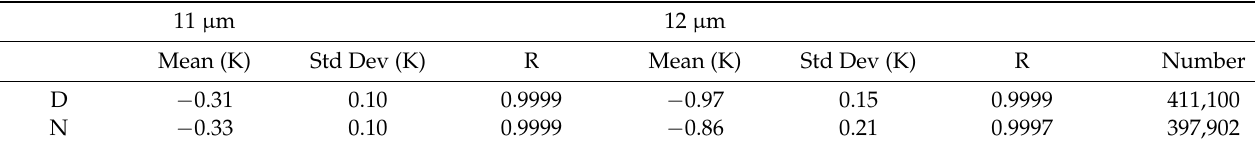
Table 2. VIRR and MODIS simulated BT difference (D means daytime, N means nighttime, R means correlation coefficient).